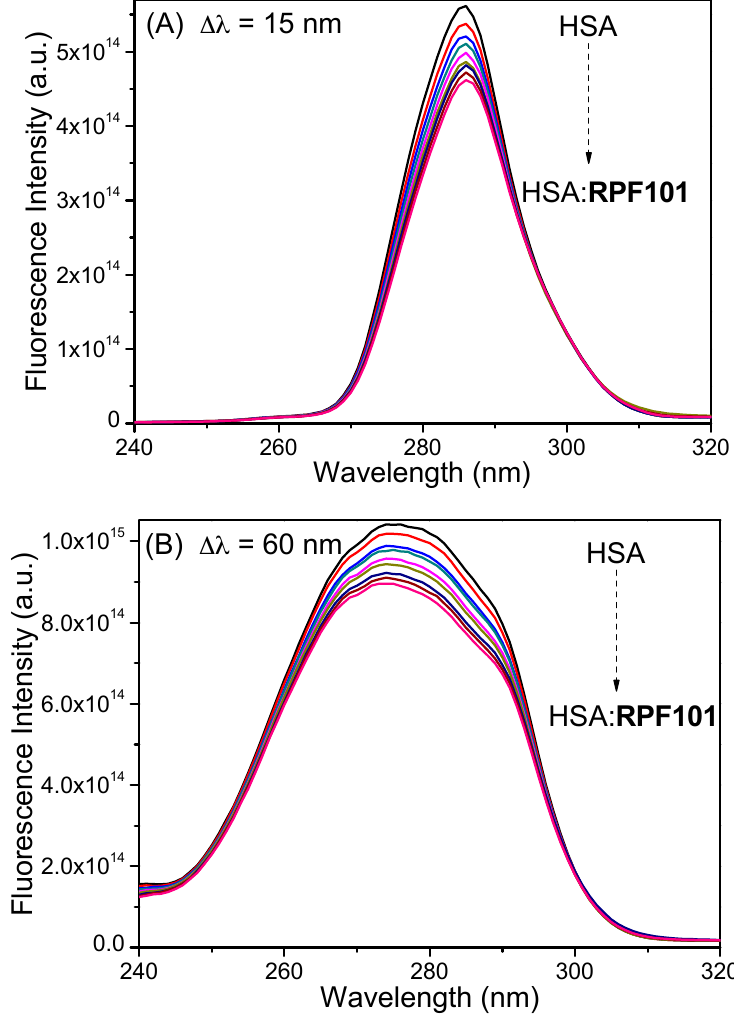
Figure 5. Synchronous fluorescence spectra for HSA without and in the presence of RPF101 at Δλ = 15 nm ( A ) and Δλ = 60 nm ( B ) in PBS solution. [HSA] = 1.00 × 10 − 5 M and [ RPF101 ] = 0.17; 0.33; 0.50; 0.66; 0.83; 0.99; 1.15; 1.32 × 10 − 5 M.